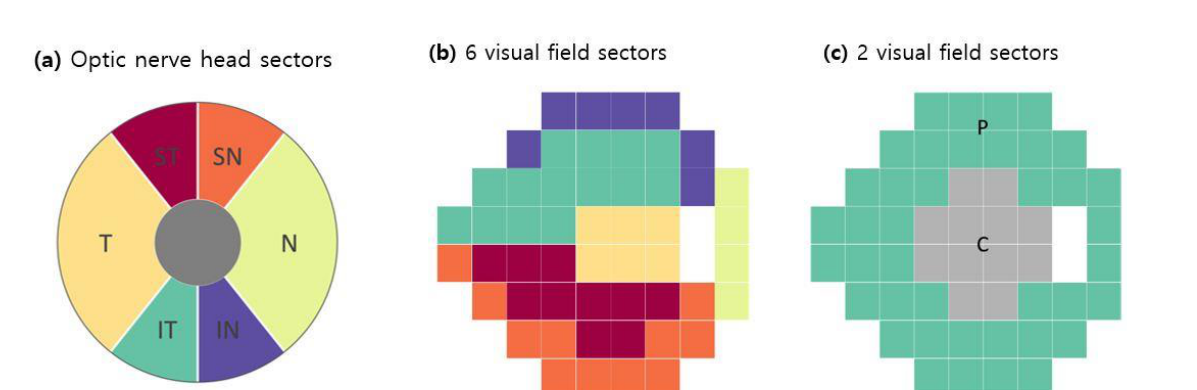
Table 10. The prediction error (MSE) by visual field partitions.